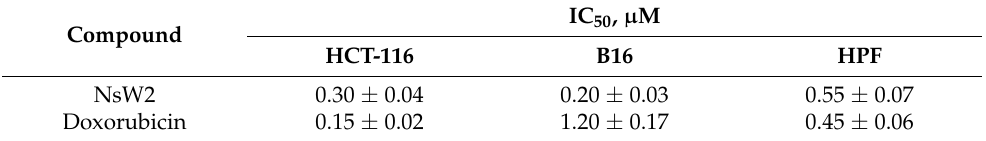
Table 5. IC 50 values of NsW2 compared with a control antitumor antibiotic (doxorubicin).